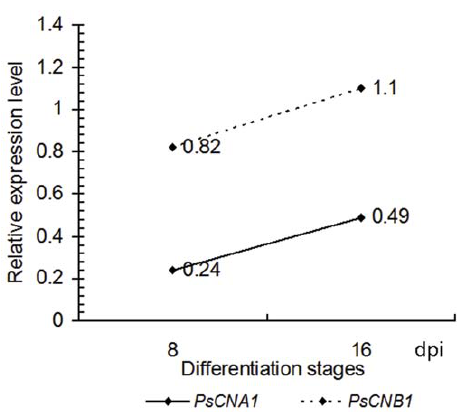
Figure 4. Transcript levels of PsCNA1 and PsCNB1 after HIGS during Pst differentiation stages. RNA samples were isolated from leaves infected with BSMV of wheat cultivar Suwon 11 inoculated with Pst race CYR31. Transcript levels of PsCNA1 and PsCNB1 were estimated by the comparative DD Ct method with elongation factor gene of Pst as the endogenous reference for normalization. dpi: days post inoculation.